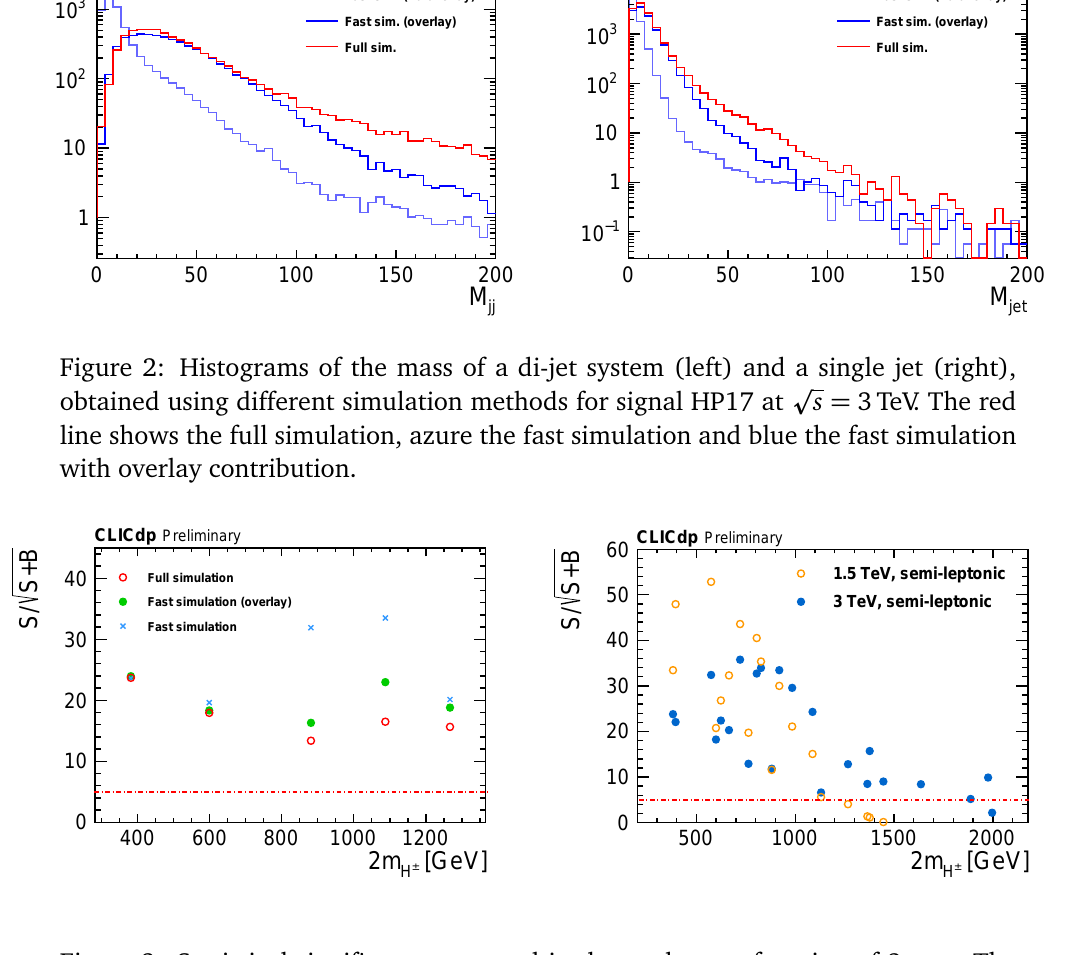
Figure 3: Statistical significance expected in the study, as a function of 2 m comparison of results obtained with different simulation methods for 3 TeV CLIC (left) and the full set of the results from fast simulation with overlay background included (right). The red dotted line shows 5 σ threshold. See text for more